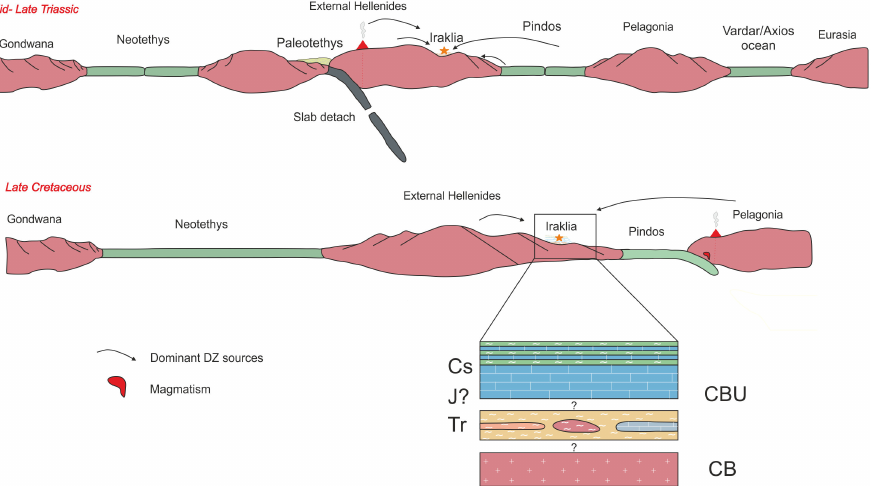
Figure 10. Schematic paleogeographic reconstruction of Iraklia island from middle–late Triassic to late Cretaceous